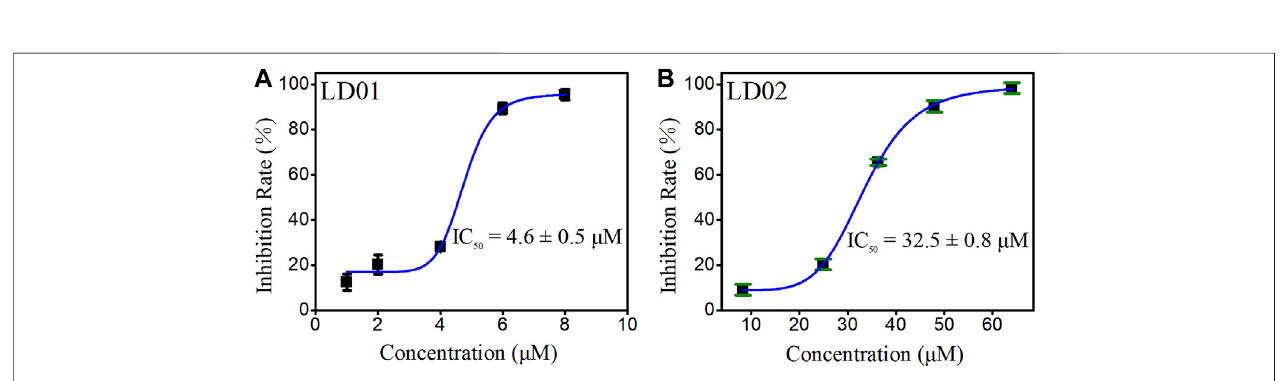
FIGURE 7 | Plot of the inhibition rate of LD01 (A) and LD02 (B) against α -glucosidase concentration.